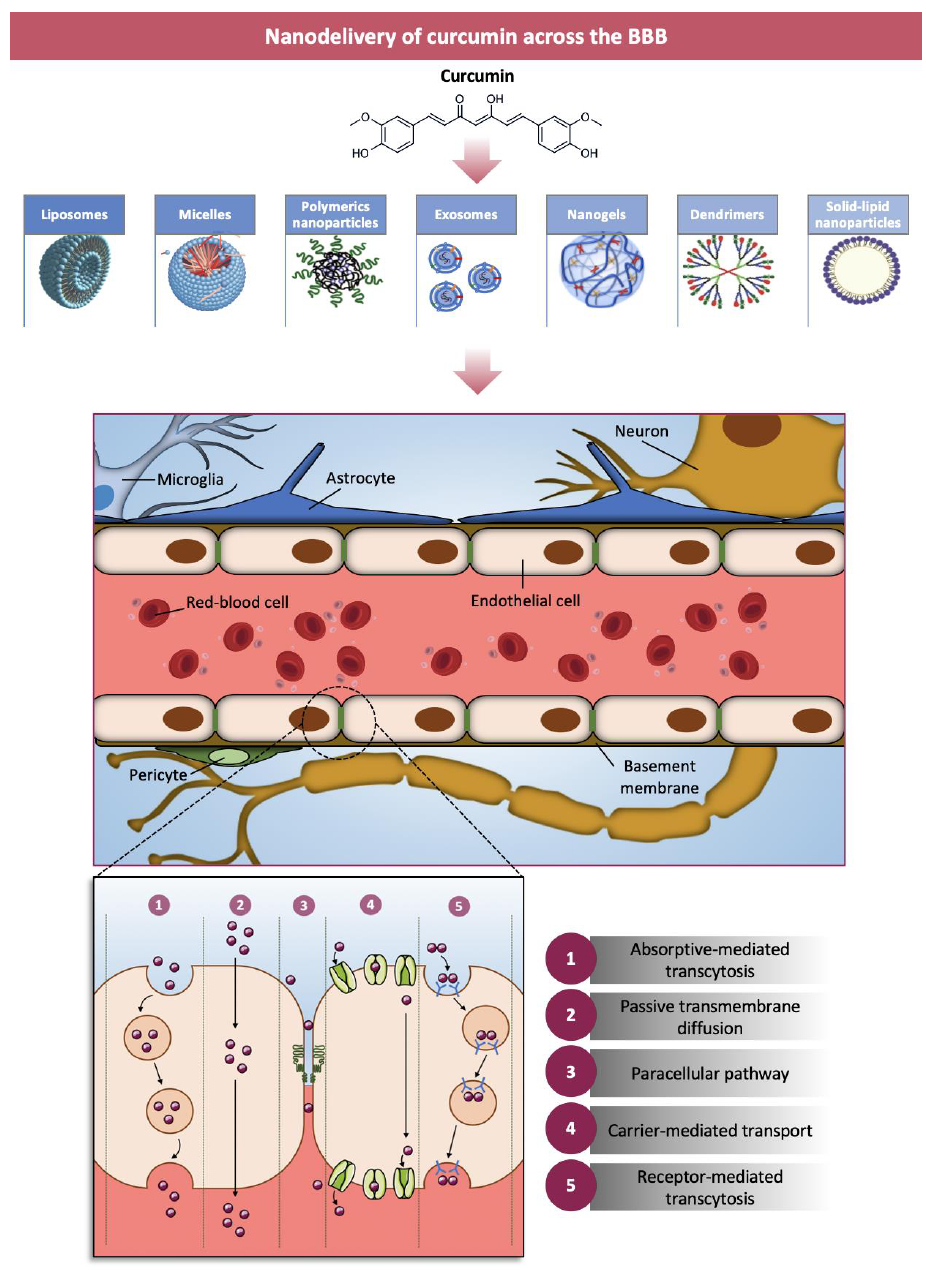
Figure 2. Main types of curcumin nanocarriers, structure of blood brain barrier (BBB) and BBB crossing modality are reported. BBB is composed of endothelial cells (ECs), pericytes (PCs) and astrocytes, whose end-feet cover the basal lamina of the brain capillaries [166,193]. There are several transport routes divided in diffusion and transcytosis by which small soluble molecules and endogenous macromolecules move across the BBB, respectively. Hydrophilic molecules and lipophilic substances diffuse between the cells through the tight junctions or move through the cells by dissolving in the plasma membrane [173]. In addition, carrier mediated transports in which, for example, SLC2/Glut1 glucose and LAT1 amino acid carriers are present, which mediate the uptake of essential nutrients [169]. Transcytosis involves endocytic vesicles shuttling from the luminal cell side to the abluminal side where the molecules are released by exocytosis. The transcytosis process can be specific or receptor-mediated (RMT) [194] and nonspecific or adsorptive-mediated (AMT) [183]. An example of regulated receptor mediated transport is represented by the entry into the ECs of transferrin, insulin and lipoprotein [195].